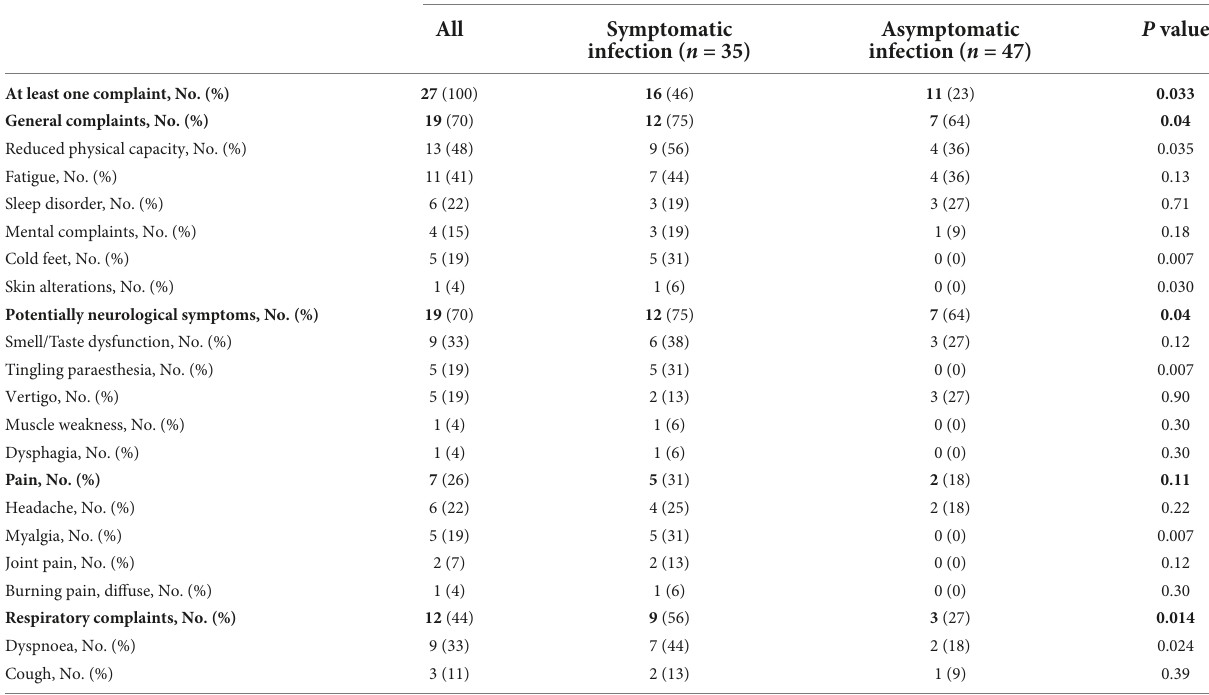
TABLE 1 Long-term complaints newly emerged after SARS-CoV-2 infection.